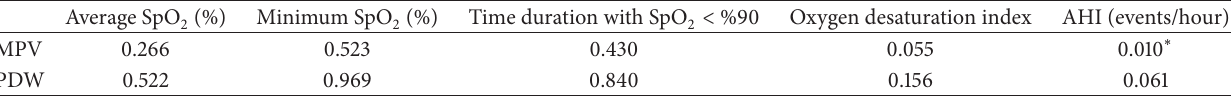
Table 4: Correlation analyses and P values of MPV and PDW with polysomnographic parameters in the whole group. Average SpO (%) Minimum SpO 2 MPV 0.875 0.647